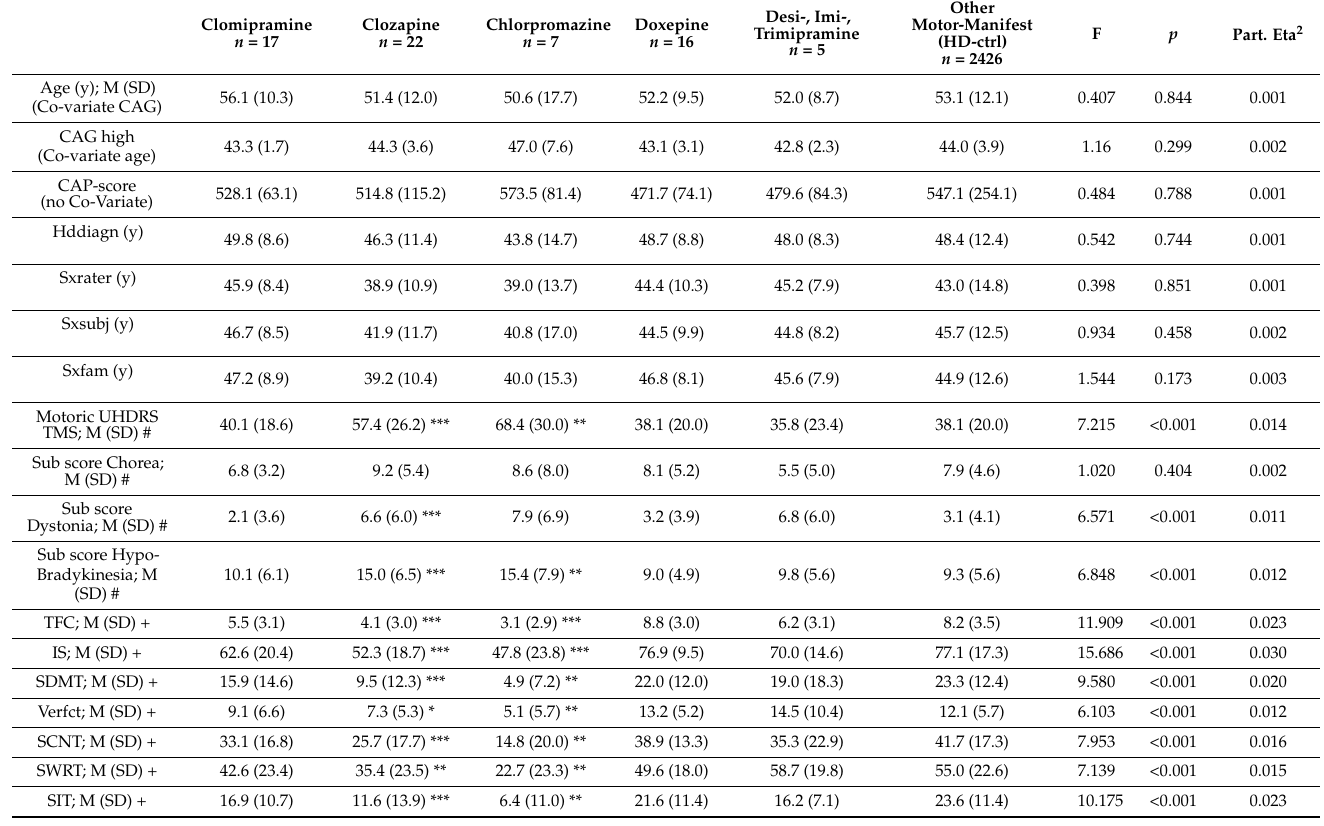
Table 2. Baseline data of patients with two years